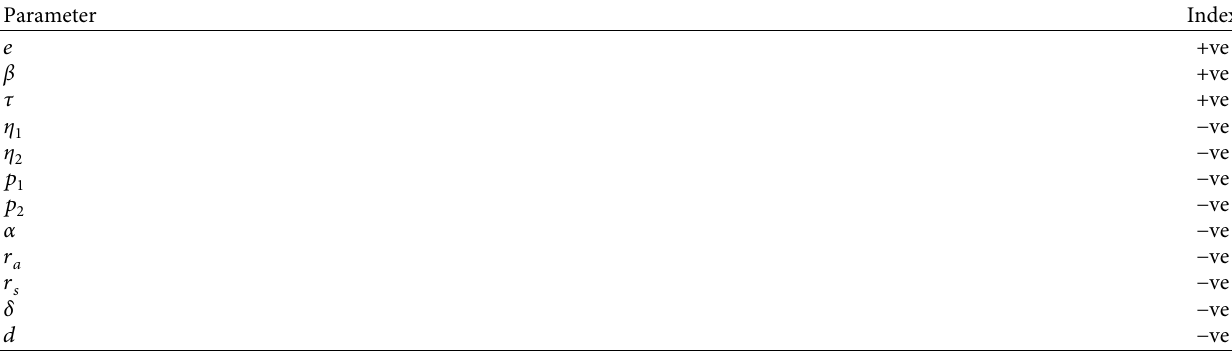
Table 1: Sensitivity index table.